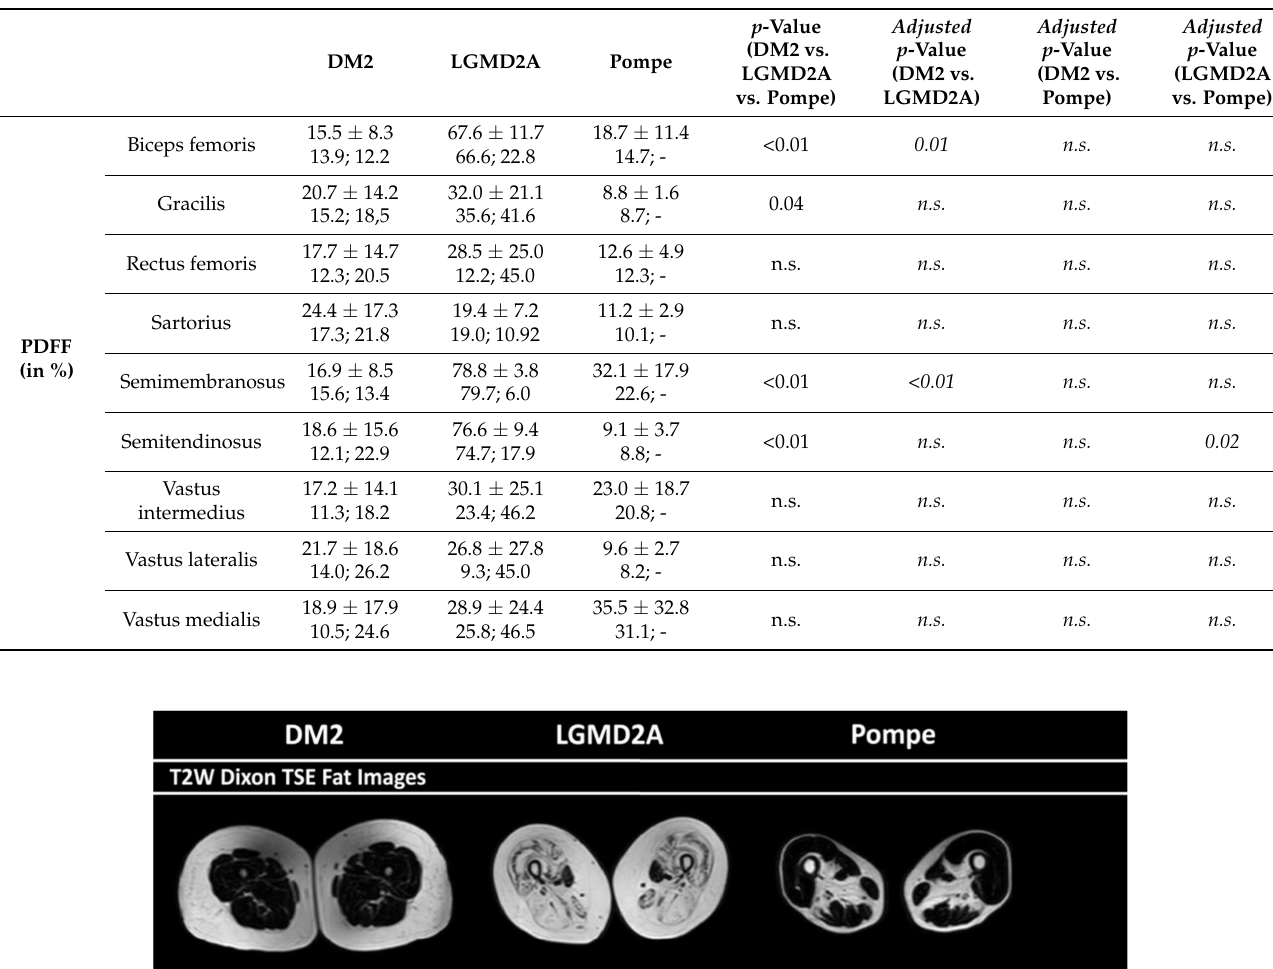
Table 5. Proton density fat fraction (PDFF) of muscles of the thigh region. Table showing PDFF (in %) for the biceps femoris, gracilis, rectus femoris, sartorius, semimembranosus, semitendinosus, vastus intermedius, vastus lateralis, and vastus medialis muscles. Values are given as mean ± standard deviation and median; interquartile range (IQR). P -values for the comparison of the three groups as well as adjusted p -values (derived from post-hoc testing, italics ) are shown (n.s.: not statistically significant, p > 0.05).